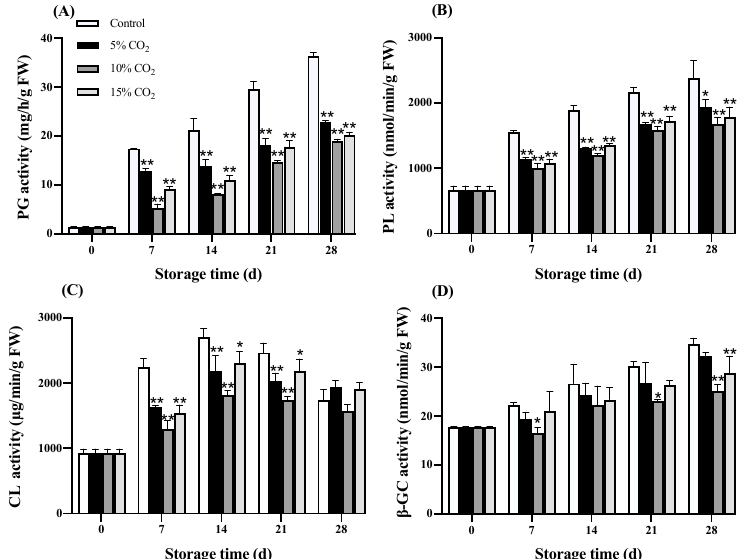
Figure 5. Effects of elevated CO 2 treatment on PG (polygalacturonase) activity ( A ), PL (pectate lyase) activity ( B ), CL (cellulase) activity ( C ), and β -GC ( β -glucosidase) activity ( D ) in wolfberry during storage at 0 ± 0.5 °C for 28 d. Significant level * p < 0.05; ** p < 0.01.